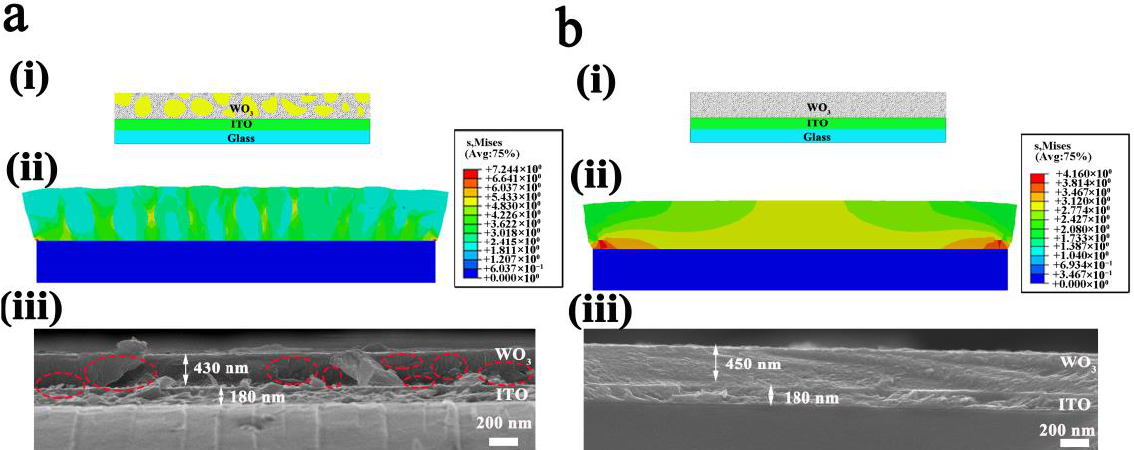
Figure 6. Failure analysis of the WO 3 films with different granularity uniformity. Nonuniform state illustration of the 50 W-deposited WO 3 film ( ai ) and uniform state illustration pf the 100 W-deposited WO 3 film ( bi ), corresponding finite element simulation analysis ( aii , bii ), and cross-sectional SEM images of the WO 3 films after 5000 CV cycles ( aiii , biii ), where red line circles indicate the cracks in the 50 W-deposited WO 3 film.